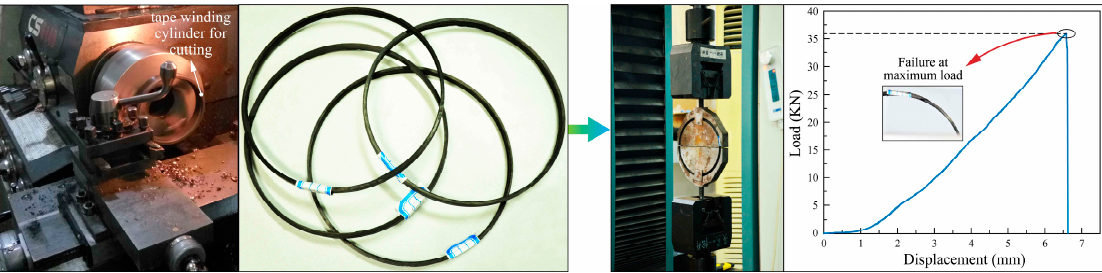
Figure 3. Experiment test samples machining and tensile strength testing process.